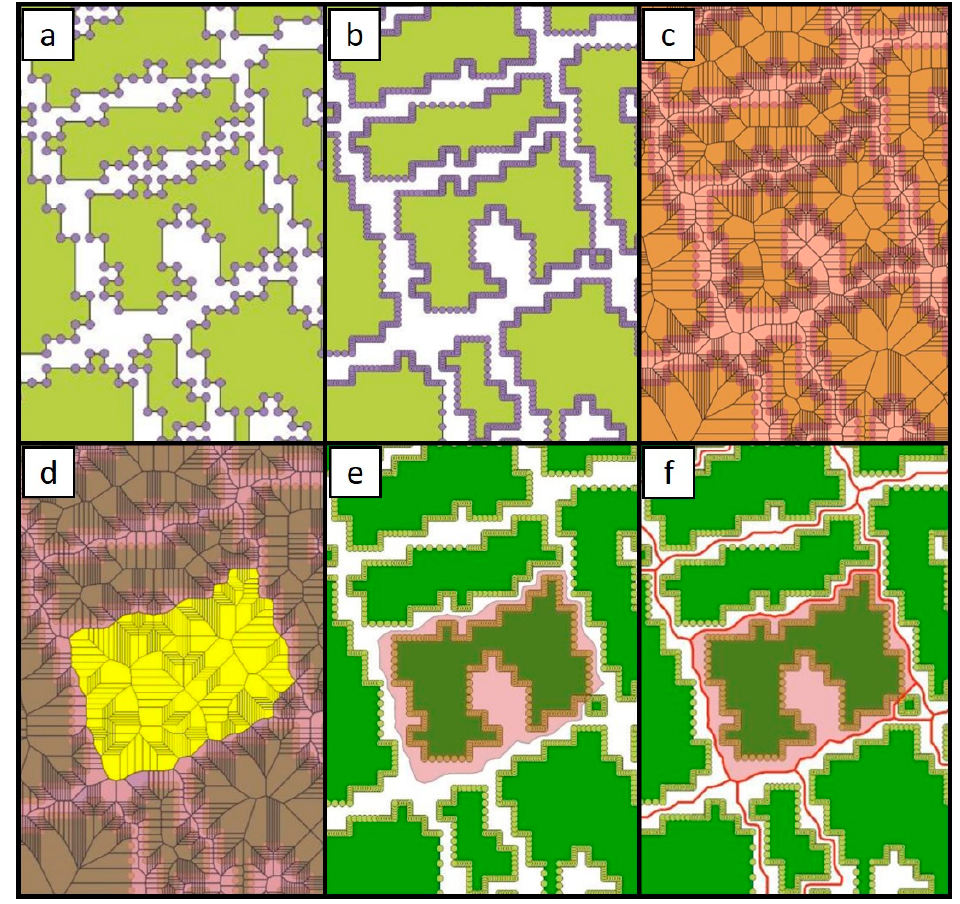
Figure 4. Graphical representation of the procedure to define a VG based on buildings’ mutual positions. ( a ) Starting from a preprocessed image (in white the points with zero height, i.e., the streets, and in green the points with non-zero height, i.e., the buildings), the sampling points (purple points) are identified over the building polygon contour partition. ( b ) The sampling points are tightened. ( c ) Creation of a VP (black lines) around each of the previously obtained points. ( d ) Merging of the VP points belonging to the same building (yellow area). ( e ) Definition of the VPb (contour of the pink area). ( f ) Definition of the street axis (red lines).